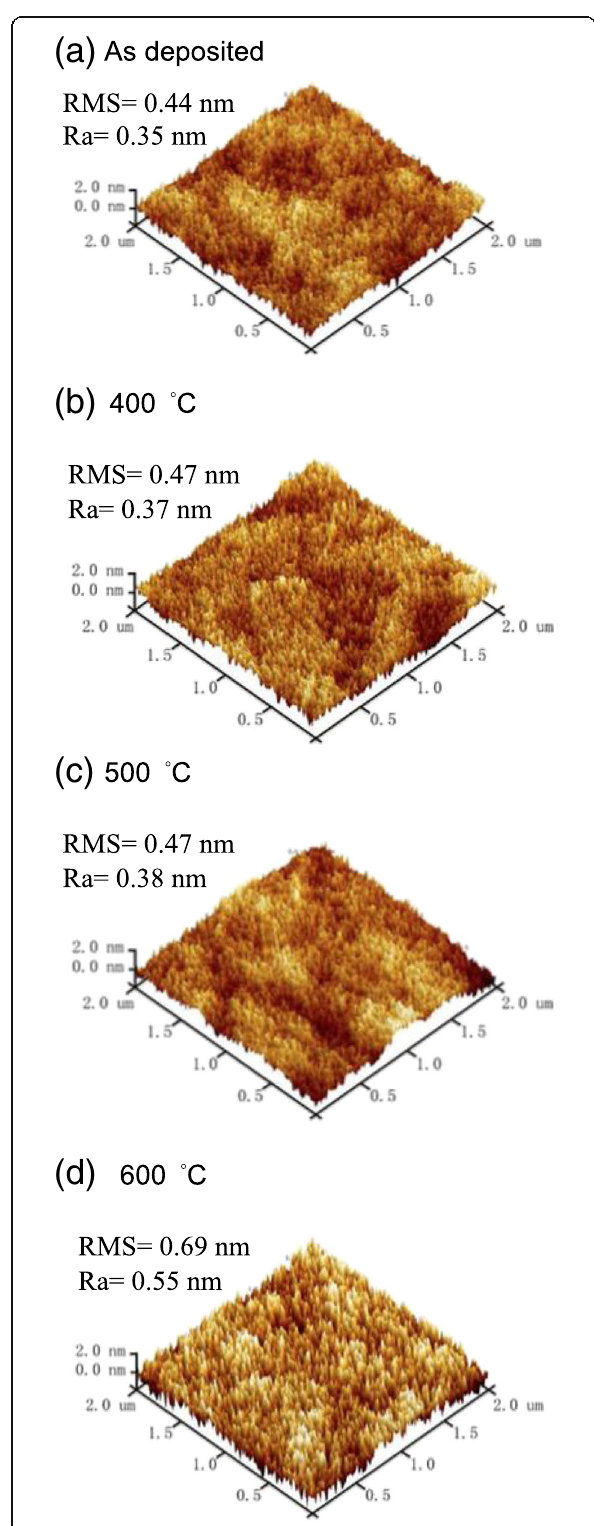
Fig. 1 AFM images of a as-deposited, b 400°C-annealed, c 500°C- annealed, and d 600°C-annealed HfO 2